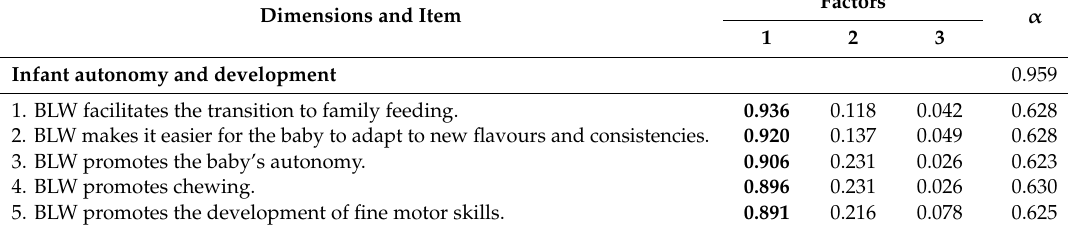
Table 2. Matrix of components and internal consistency of the PaPerc-BLW questionnaire.